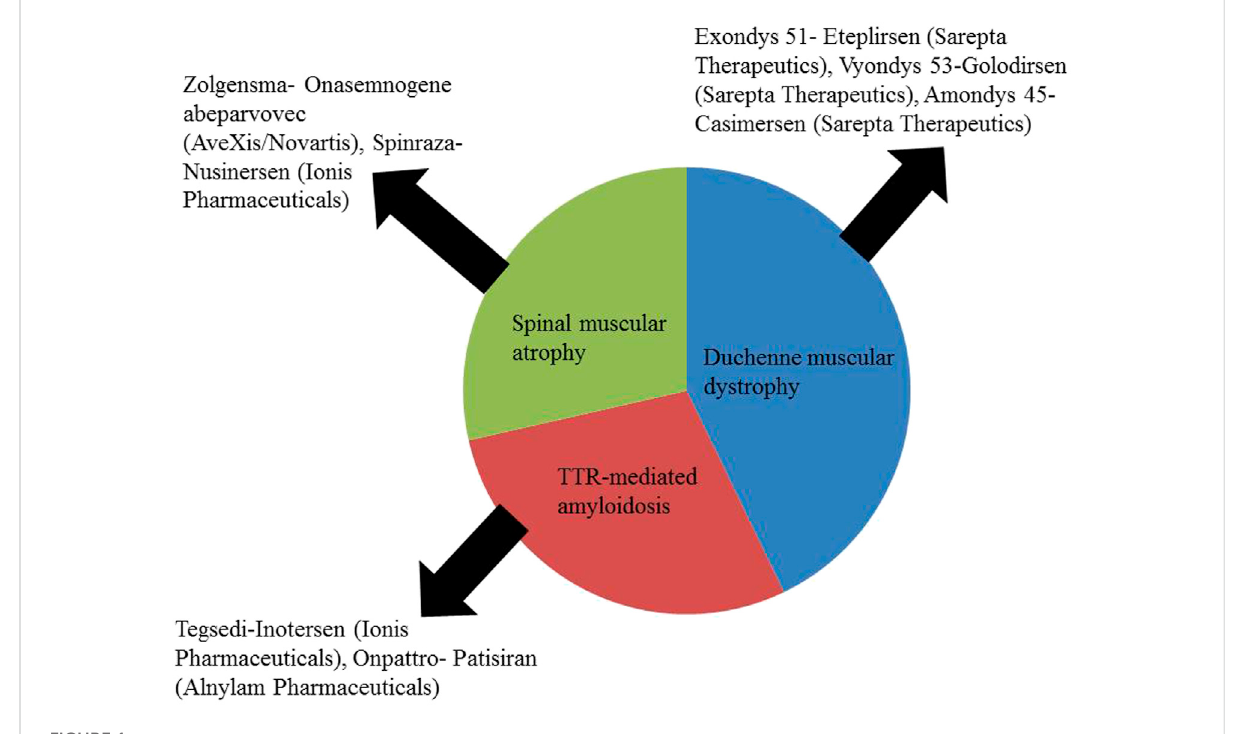
FIGURE 1 Approved NBTs for the treatment of CNS disorders (Kulkarni et al.,